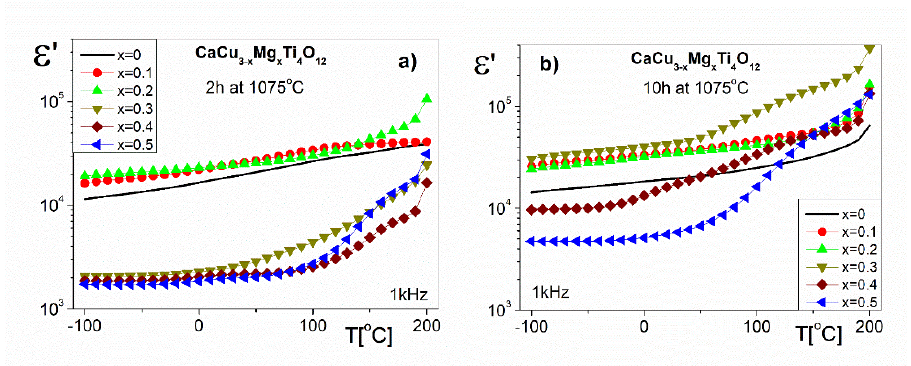
Figure 7. The temperature dependence of the real part of the dielectric permittivity for CaCu 3 − x Mg x Ti 4 O 12 sintered at 1075 °C for 2 h ( a ) and for 10 h ( b ).